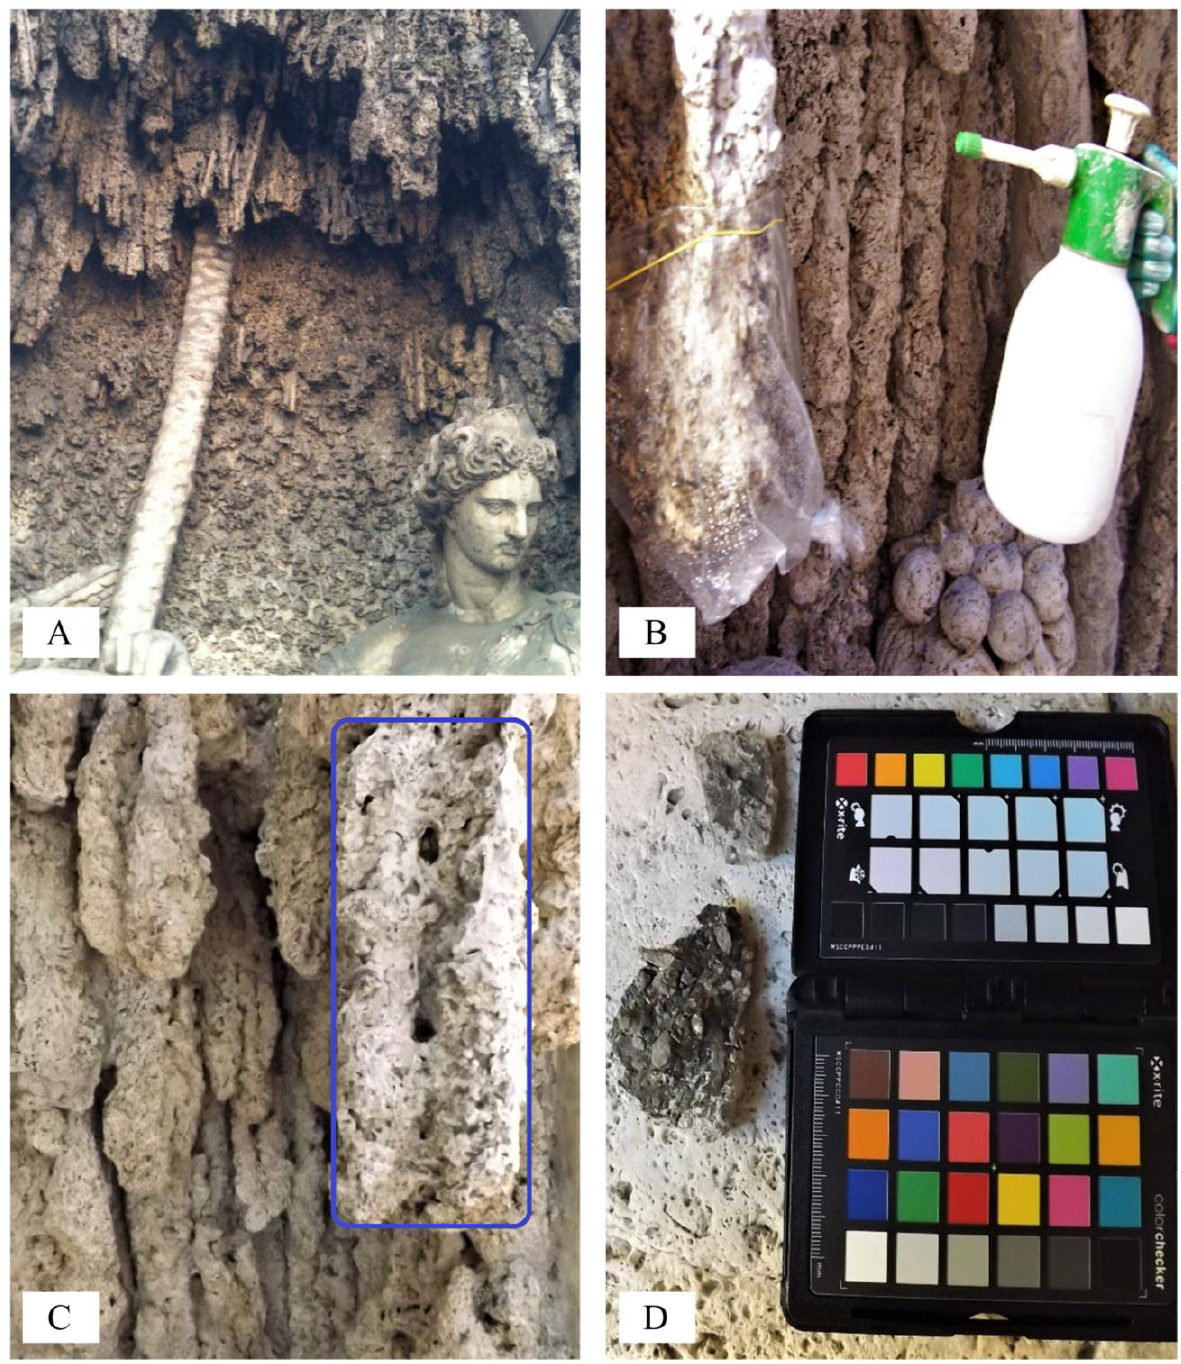
FIGURE 2: Views of the fountain depicting Juno during the biocleaning process. Detail of the dark-ridge representative of the fountain ornaments (A) ; detail of the dry biocleaning process on travertine material ornaments before and after (B, C) the dry cleaning technique, and color scale by digital camera and ColorChecker X-Rite (D)